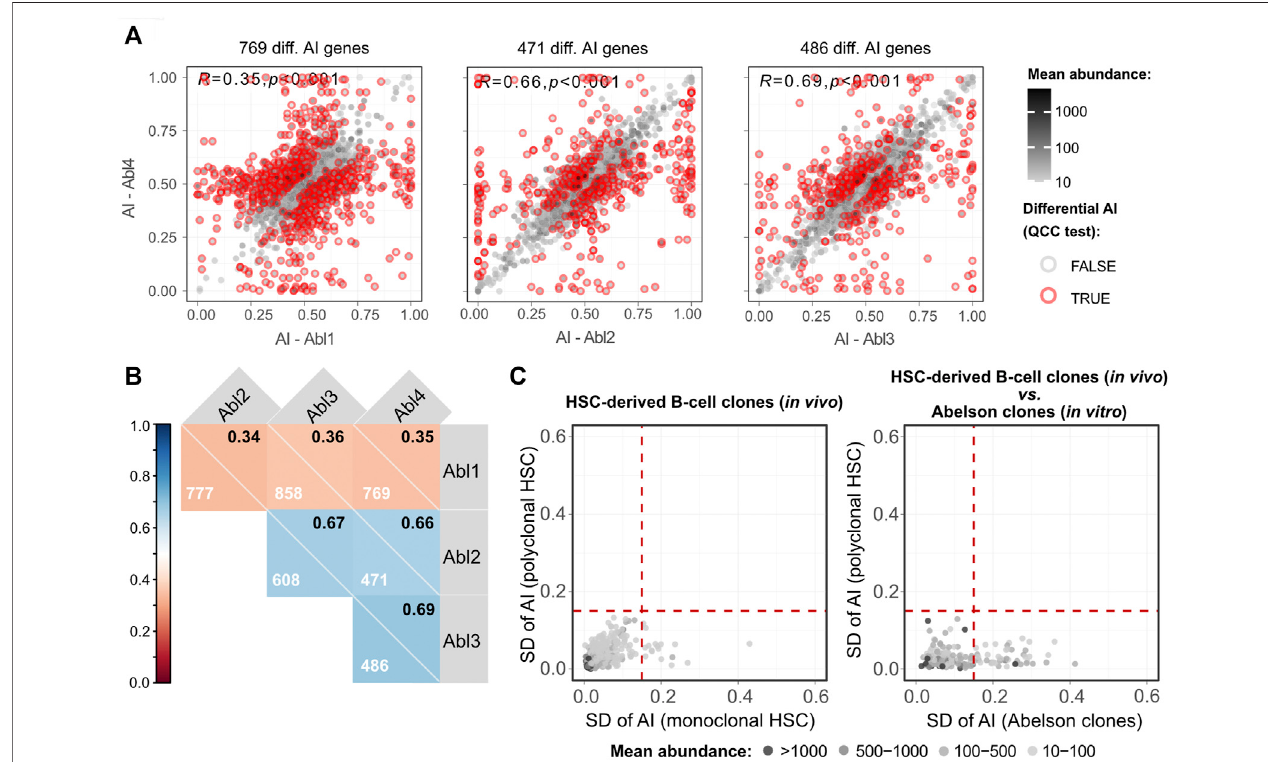
FIGURE5| Abelsonclones showahigher number ofgeneswithclonal-speci fi cAIthanlymphocytesdifferentiated fromasingle HSC. (A) Representativedot plots of pairwise comparisons of AI between different Abelson-immortalized B cell clones. Pearson ’ s coef fi cient correlation of AI and the number of genes with a signi fi cant differentialAI(aftertheQCCtest)betweensamplesareshown.Meanabundancelevels(meanTMM-normalizedcounts)arerepresentedascontinuousgrayscalecolors. (B) Correlogram with pairwise comparisons of Abelson-immortalized B cell clones. Pearson ’ s coef fi cient correlation of AI for all pairwise comparisons between samples. Each square shows the Pearson ’ s coef fi cient in the upper right corner and the number of genes with a signi fi cant differential AI in each pairwise comparison after applying QCC correction on the binomial test. (C) Two dot plots showing SDs of AIs for four monoclonal ( x-axis ) against four polyclonal ( y-axis ) HSC-derived B cell samples (left plot), and SD of AI for all four Abelson clones ( x-axis ) against the SD ofAI for four polyclonal HSC-derived B cell samples ( y-axis ) (right plot). WES data were used to exclude transcripts with possible loss of heterozygosity. Dashed vertical and horizontal lines represent the threshold above which genes were considered as potentially intrinsically imbalanced and were arbitrarily set at an AI SD of 0.15. Mean abundance levels (mean TMM-normalized counts) are represented as binned grayscale